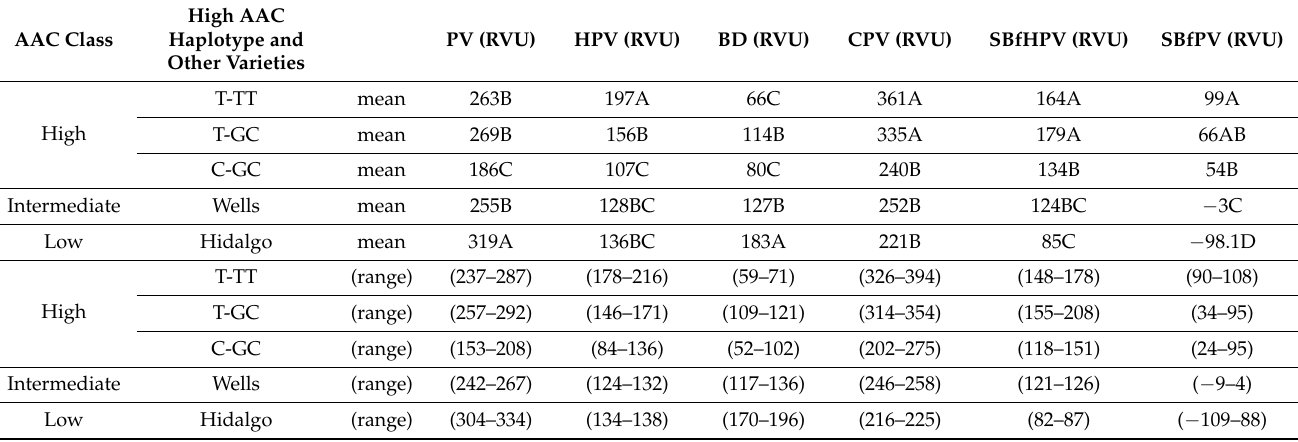
Table 3. Viscosity properties of all rice varieties †